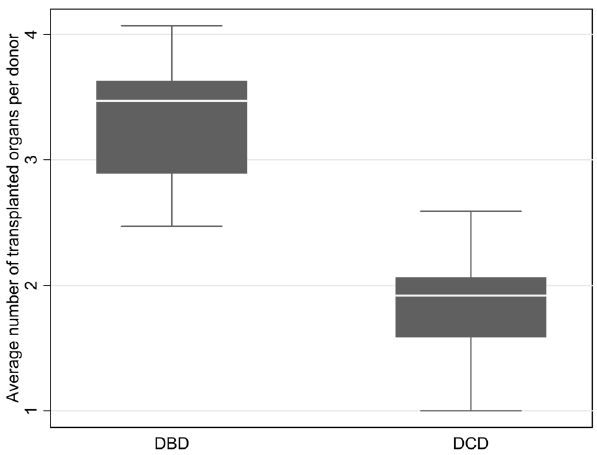
Figure 5. Boxplots of Average Number of Transplanted Organs per DBD and DCD Donor. Mean difference for number of transplants by donor type=1.51 (95% CI: 1.42,1.60, p , 0.001).